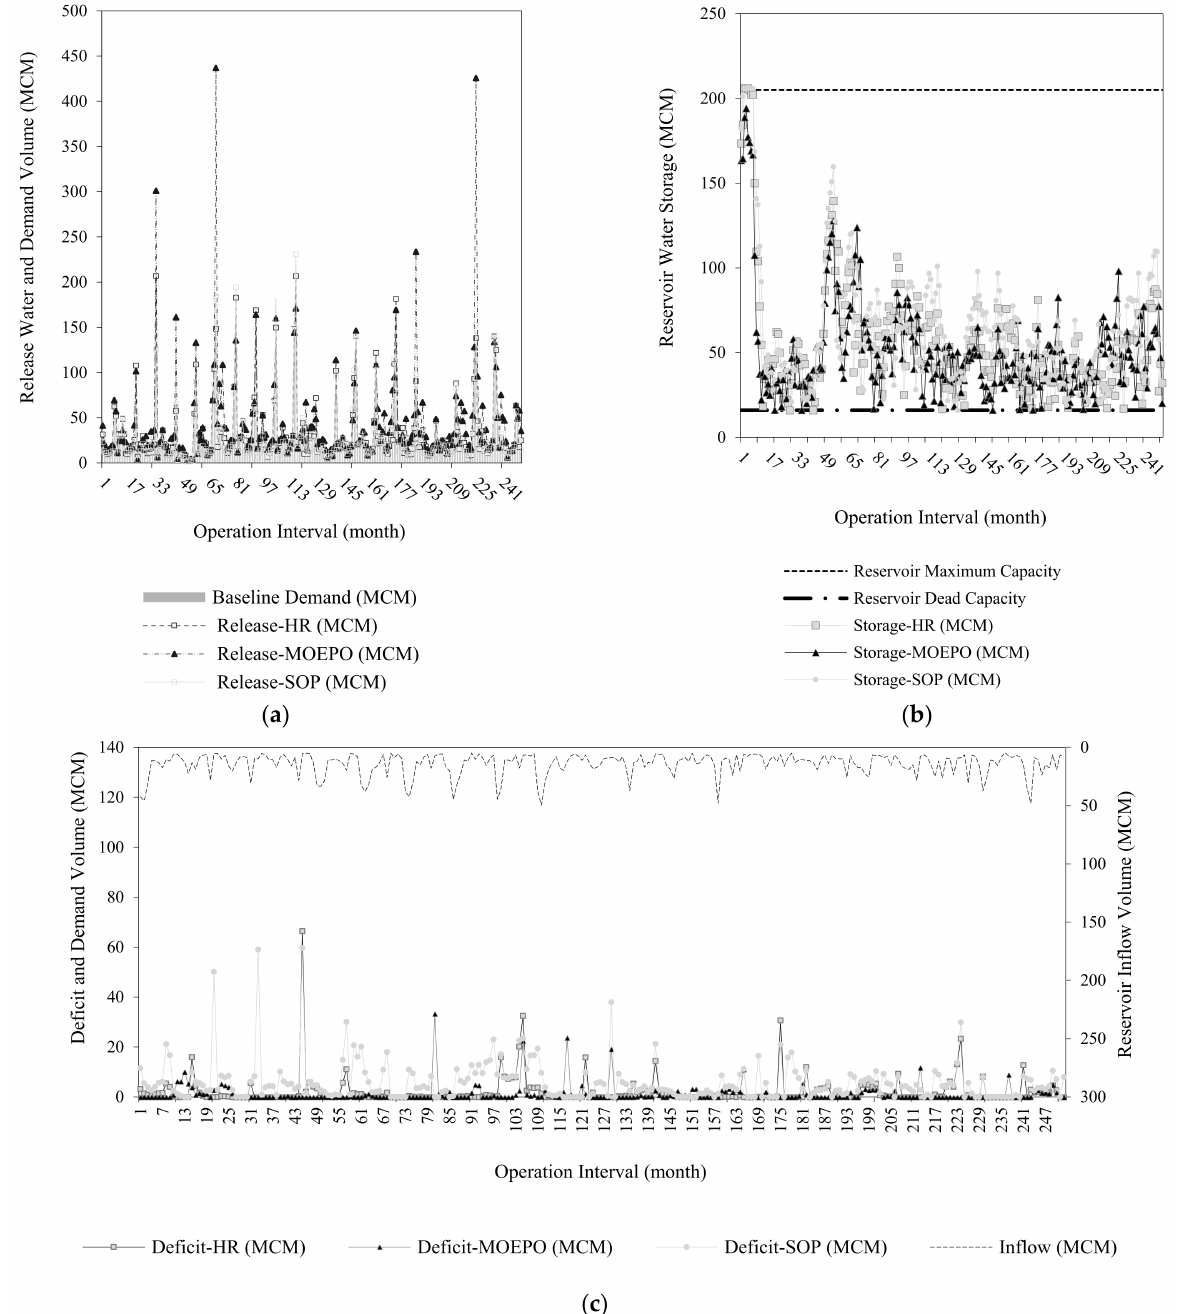
Figure 10. Comparison of: ( a ) Released volume; ( b ) Storage volume; ( c ) Deficit volume, corresponding to the second